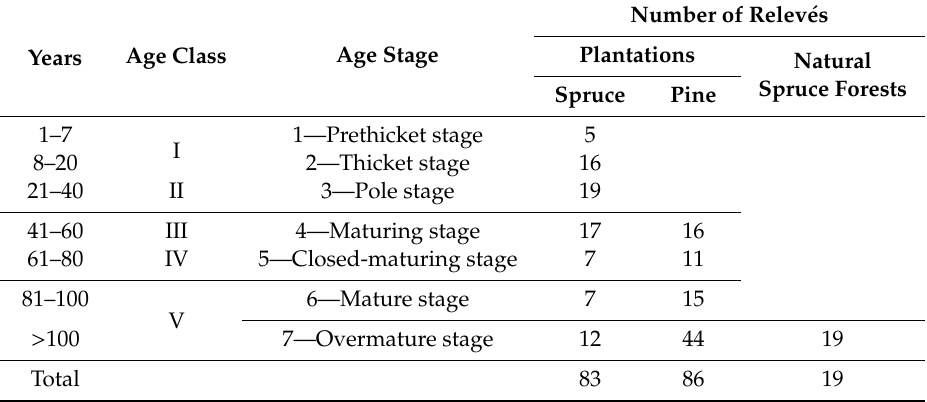
Table 1. Age classes of studied forest communities and number of relev é